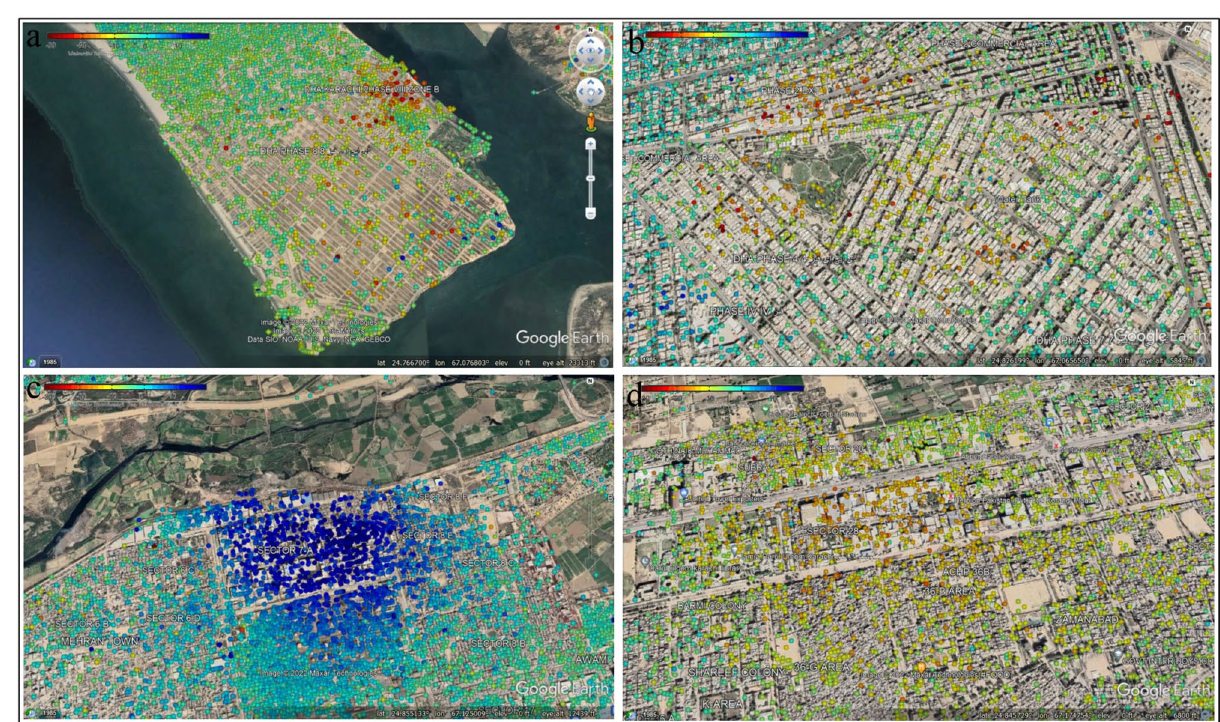
Figure 10. Vertical deformation (subsidence) in Karachi City presented on the google earth image.